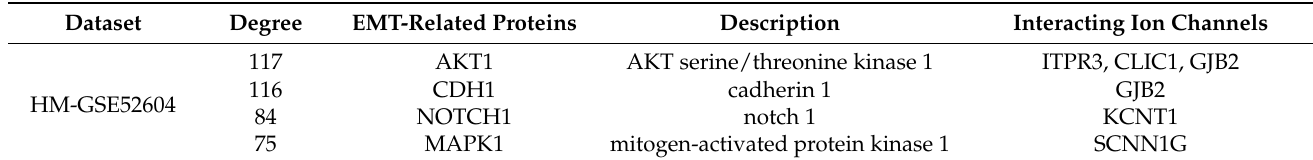
Table 7. A list of ion channels interacting with top 15 EMT-related proteins with the highest degree centrality measure in protein–protein interaction networks of modules on HM DEGs in breast cancer GSE52604